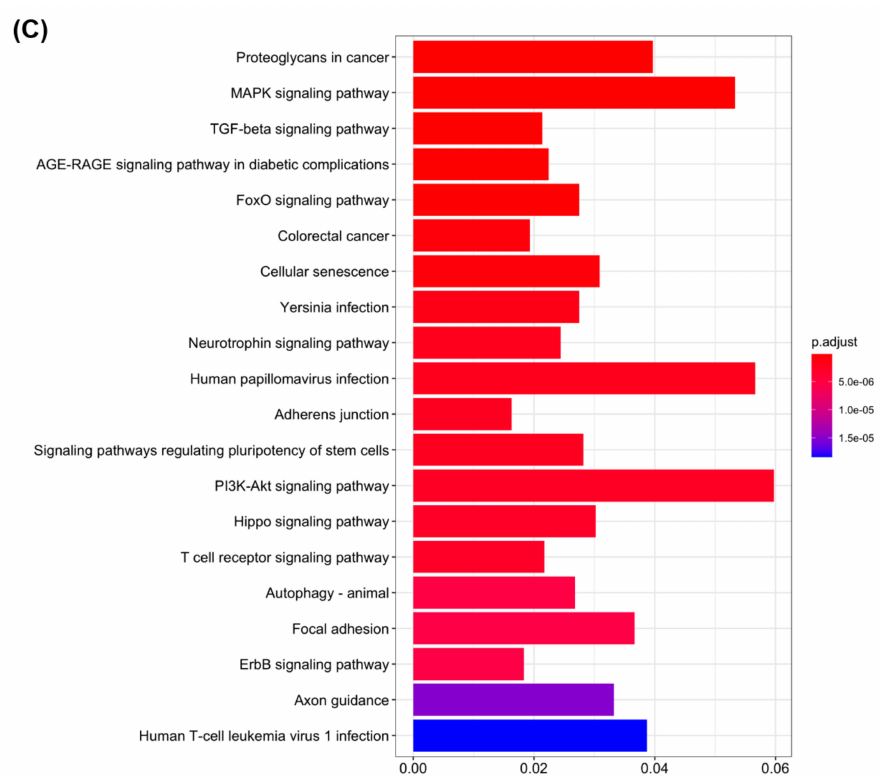
Figure 1. Differentially expressed circulating miRNAs were identified in urine from healthy volun- teers and patients with bladder cancer using next-generation sequencing. ( A ) Flowchart of 10 NGS profiles. Circulating miRNAs with differential expression were filtered with a fold change of ≥ 2 or <0.25. ( B ) Heatmap presenting the upregulation or downregulation of circulating miRNAs in patients with bladder cancer. ( C ) Targets of differentially expressed miRNA candidates were identified using a target prediction tool and pathway enrichment